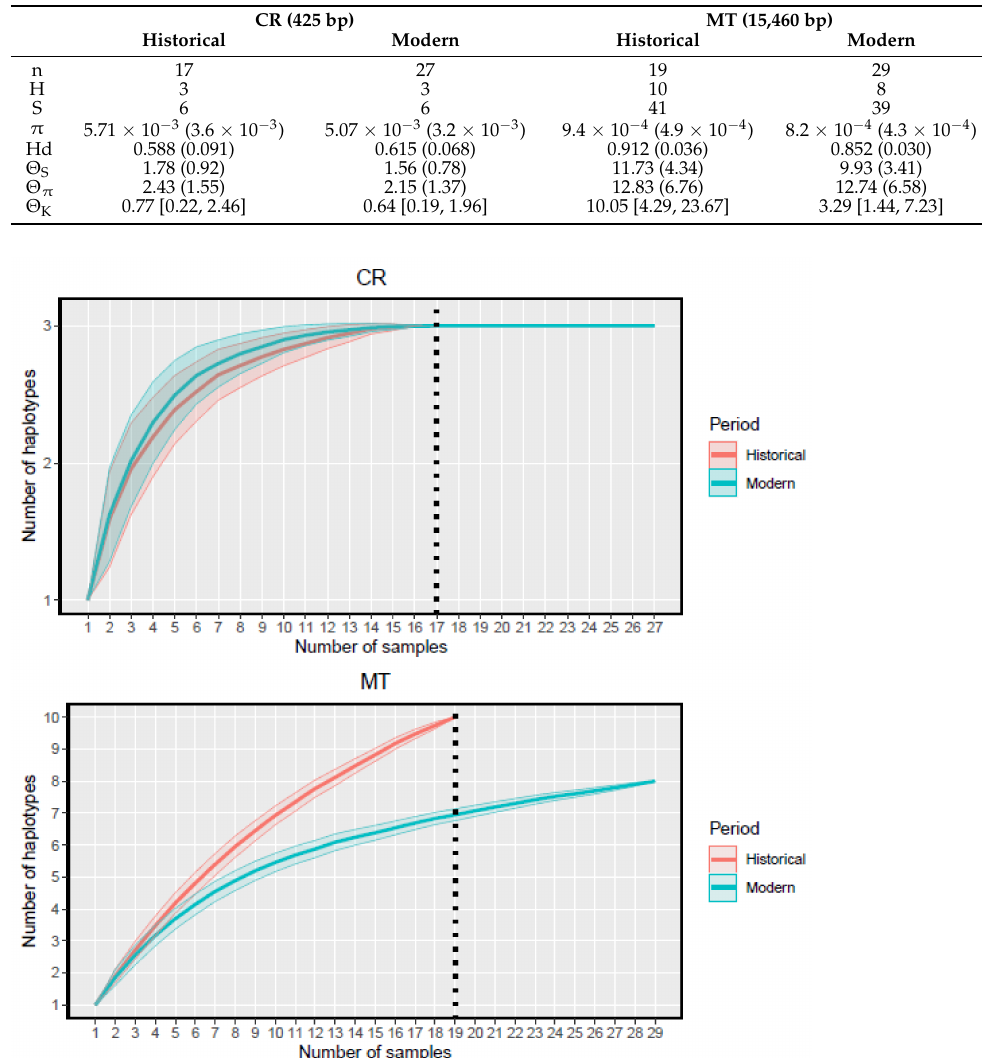
Table 4. Diversity indices and number of haplotypes from historical and modern Iberian wolves based on sequence of the 5 (cid:48) end of the control region (CR) or the whole mitochondrial genome except the control region (MT). n, number of sequences; H, number of haplotypes; S, number of polymorphic sites; π , nucleotide diversity; Hd, haplotype diversity; Θ S , theta calculated from the observed number of segregating sites; Θ π , theta calculated from the mean number of pairwise differences of nucleotide diversity; Θ K , theta calculated from the observed number of haplotypes; bp, base pairs. Standard deviations are shown in parentheses, 95% confidence intervals in brackets.